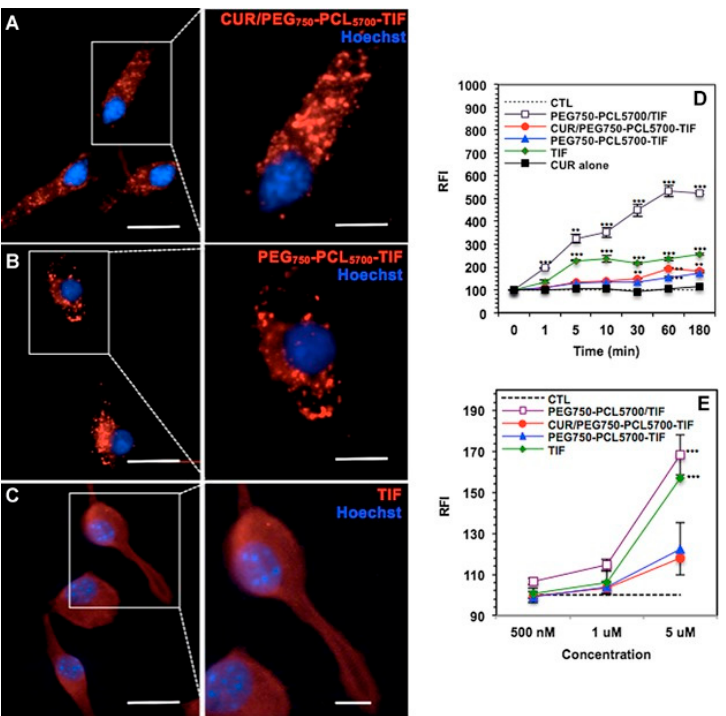
Figure 6. Fluorescent micrographs of macrophages treated with ( A ) curcumin-loaded PEG-PCL-TIF micelles, ( B ) unloaded PEG-PCL-TIF micelles, and ( C ) TIF control. Relative fluorescence intensities of macrophages treated with control media, TIF-loaded PEG-PCL micelles, curcumin-loaded PEG-PCL-TIF micelles, unloaded PEG-PCL-TIF micelles, free TIF, and free curcumin as a function of ( D ) treatment time and ( E ) dose concentration. Scale bar = 20 μ m, inset scale bar = 10 μ m. Statistically significant differences are represented by ** ( p < 0.01), and *** ( p < 0.001). Reprinted with permission from reference [49] . Copyright 2014 John Wiley and Sons.